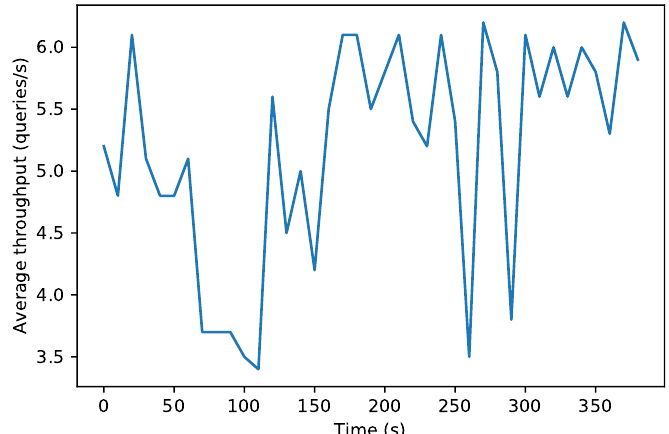
Figure 13. Performance of the cloud OrbitDB node executing 2000 queries.